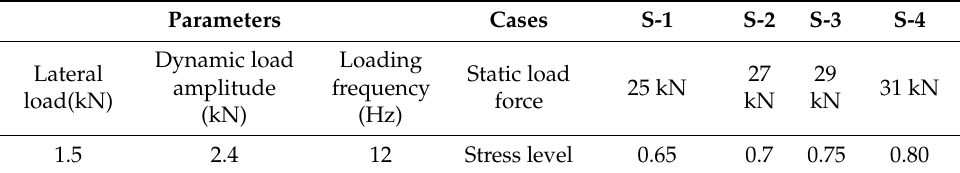
Table 5. Case for different levels of static load (stress level).